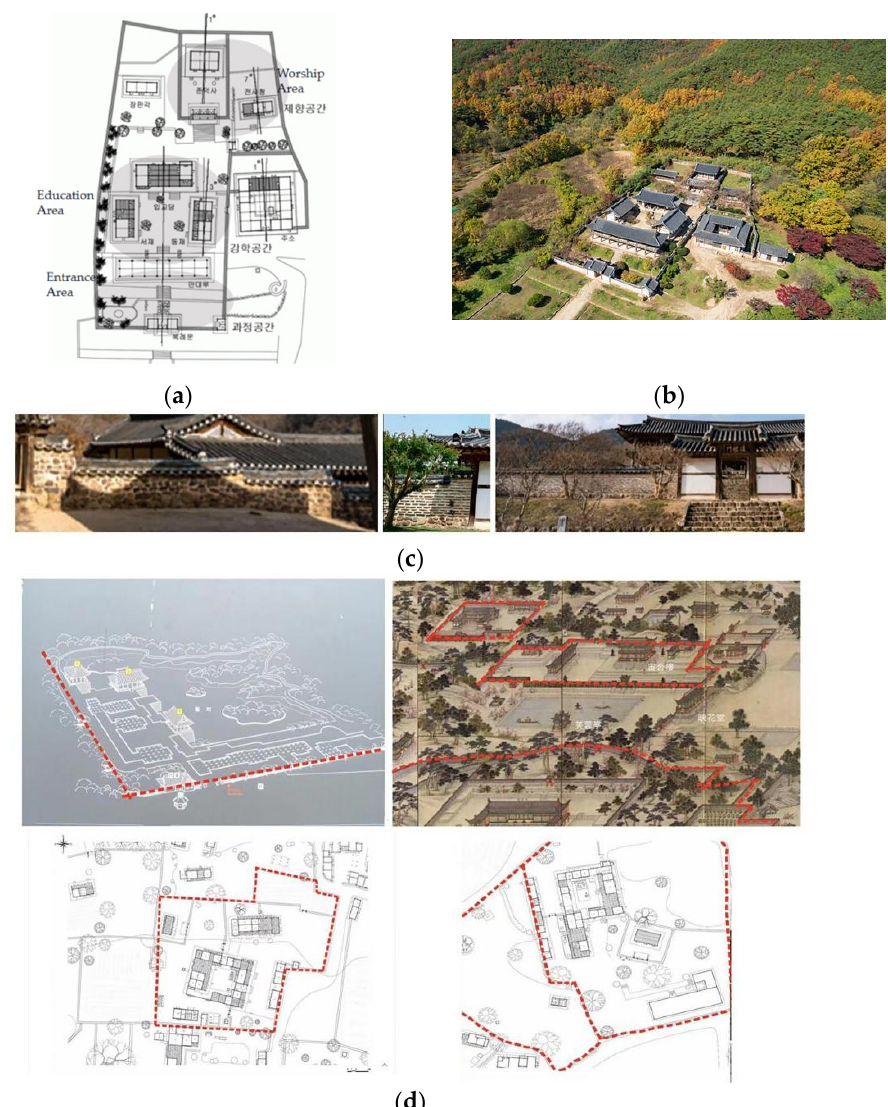
Figure 6. ( a ) Floor plan of Pingshan Academy (source: Jong-Hee Choi); ( b ) a bird's eye view of Pingshan Academy (source: internet); ( c ) the wall of Pingshan Academy (source: Sang-Hae Lee); ( d ) traditional Korean architectural wall styles: Anapji, Changde Temple, Ho Hui Village's North Village, and Ho Hui Village's Chung Hsiao Hall (source: Sang-Hae Lee).